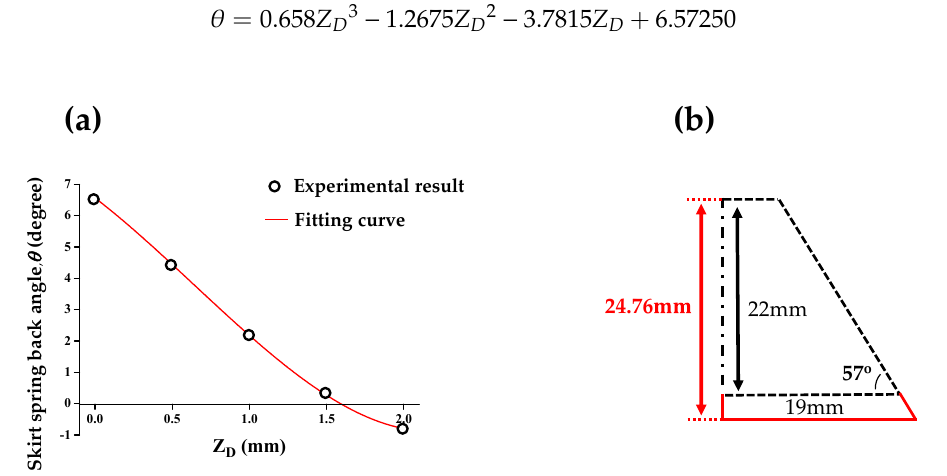
Table 6. Comparison of hull shape according to each process. Figure 17. Compensation result of ( a ) the skirt spring-back and ( b ) the final forming height.